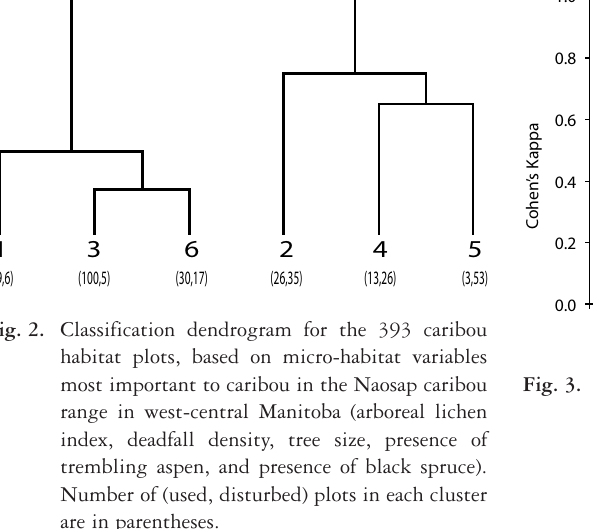
Fig. 2. Classification dendrogram for the 393 caribou habitat plots, based on micro-habitat variables most important to caribou in the Naosap caribou range in west-central Manitoba (arboreal lichen index, deadfall density, tree size, presence of trembling aspen, and presence of black spruce). Number of (used, disturbed) plots in each cluster are in